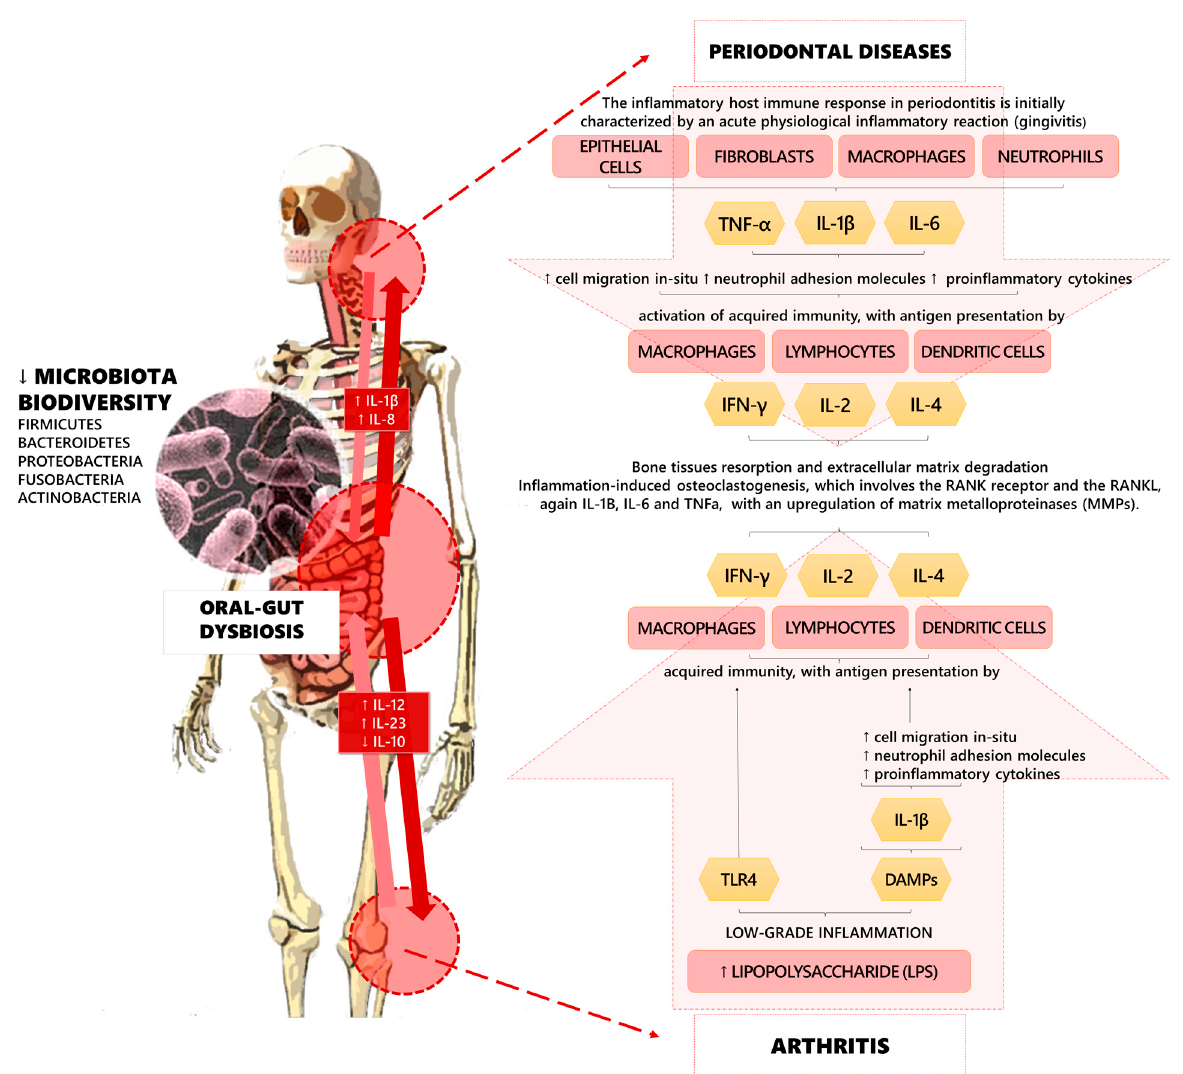
Figure 1. Pathogenic pathways of the linkages among oral–gut dysbiosis, periodontal diseases, and arthritis.